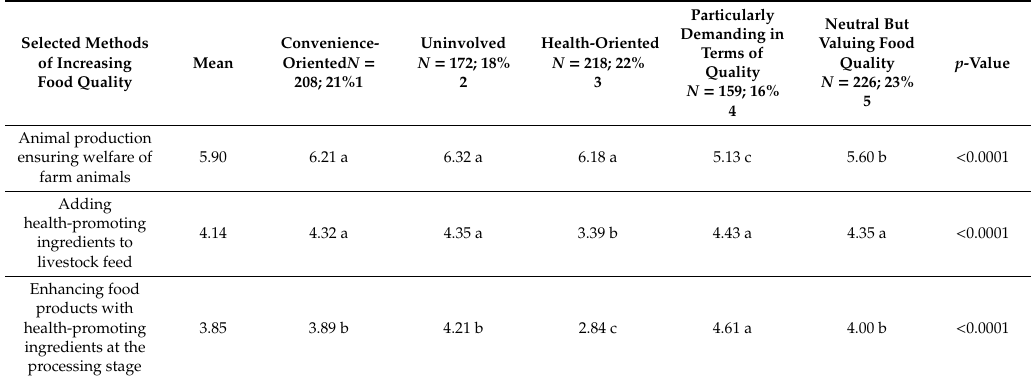
Table 4. The level of acceptance of methods to increase food quality of animal origin in the opinion of